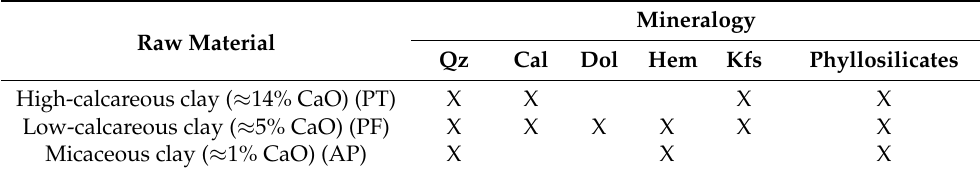
Table 4. Summary of the mineralogical phases of the clays used for manufacturing the ceramic pastes. Qz = quartz; Cal = calcite; Dol = dolomite; Hem = hematite; Kfs = potassium